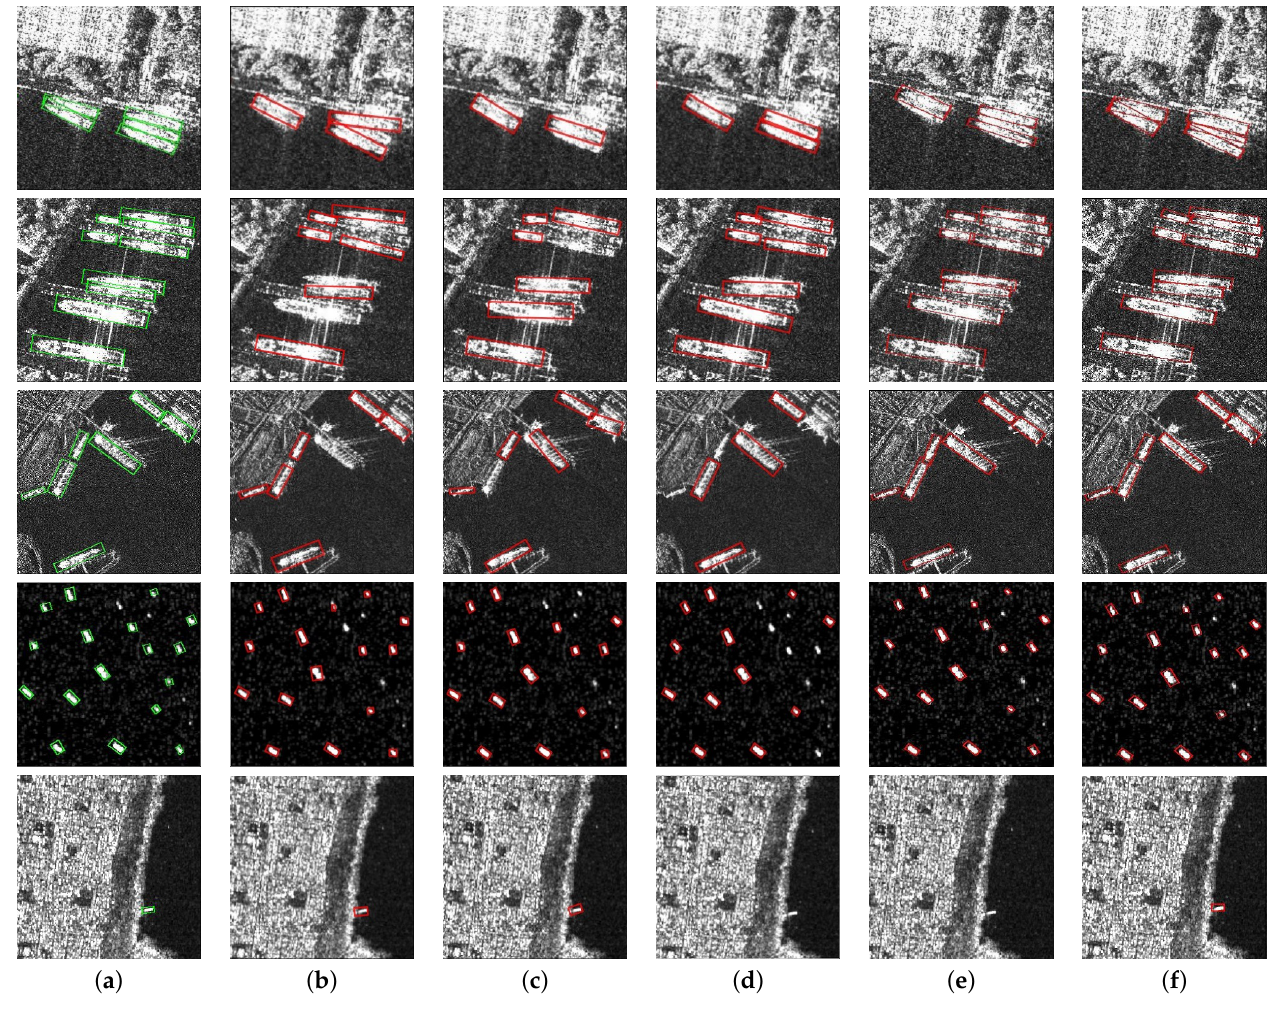
Figure 13. Detection results of the different detection methods: ( a ) ground truth; ( b ) Rotated- Retinanet; ( c ) ROItransformer; ( d ) Rotated-FCOS; ( e ) BBAVectors; ( f ) our proposed method (Dla34+FSM). First three rows: inshore large ship targets in the SAR image. Fourth row: offshore small ship targets in the SAR image. Fifth row: inshore small ship targets in the SAR